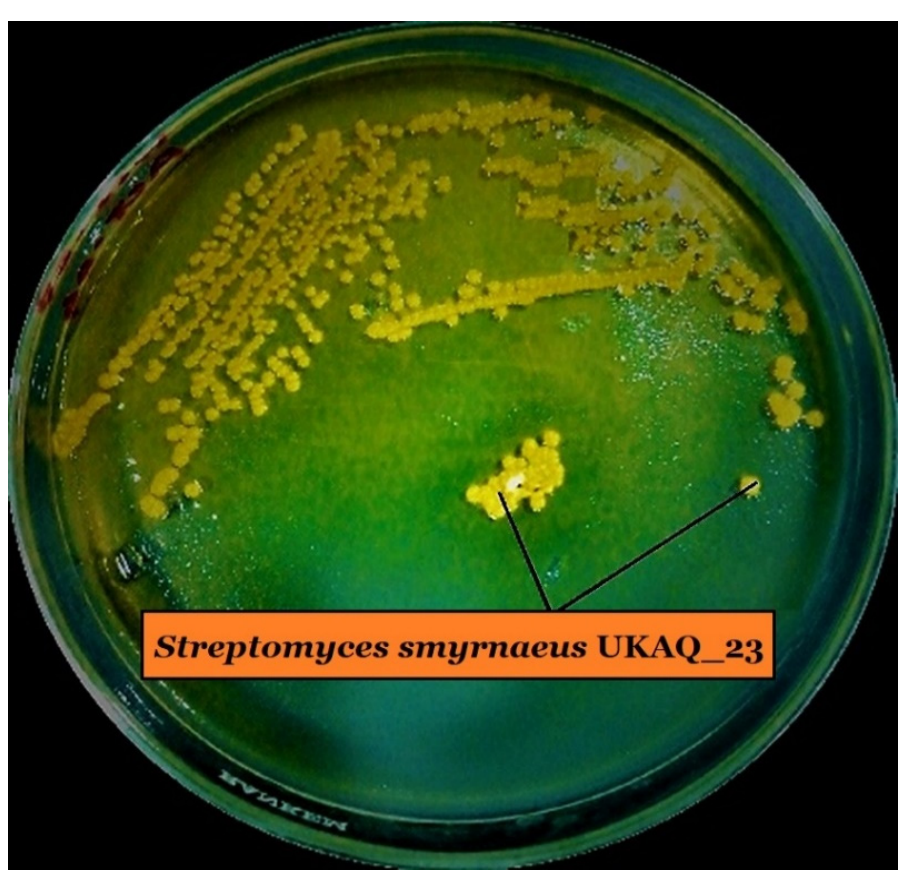
Figure 1. Growth of isolated strain UKAQ_23 on ISP-4 agar at 28 °C for 7 days.